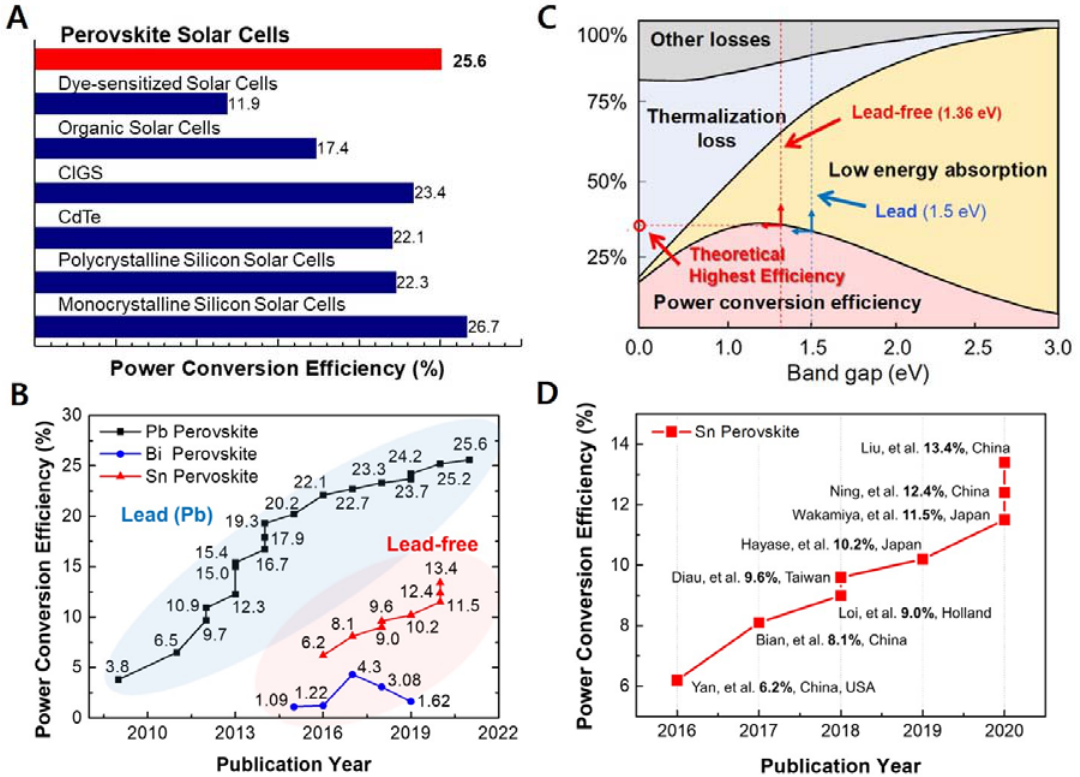
Figure 1. ( A ) Bar graph showing the highest certified PCEs of the different types of photovoltaics. ( B ) Reported PCEs of Pb-based, Bi-based, and Sn-based PSCs from the initial stage of development to date. ( C ) Shockley–Queisser limit graph showing the PSC type that has a relatively high ideal bandgap. ( D ) PCE chart showing the development of Sn-PSCs.